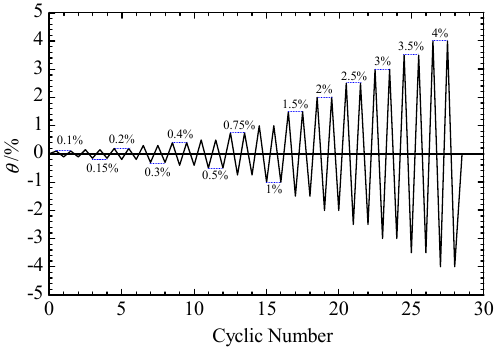
Figure 5. The loading protocol.